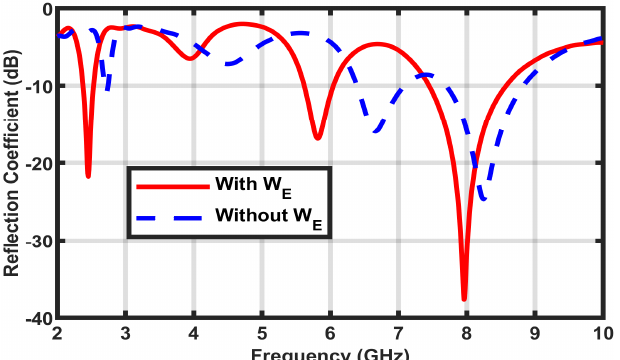
Figure 7. Effect of adding a horizontal strip on the reflection coefficient.